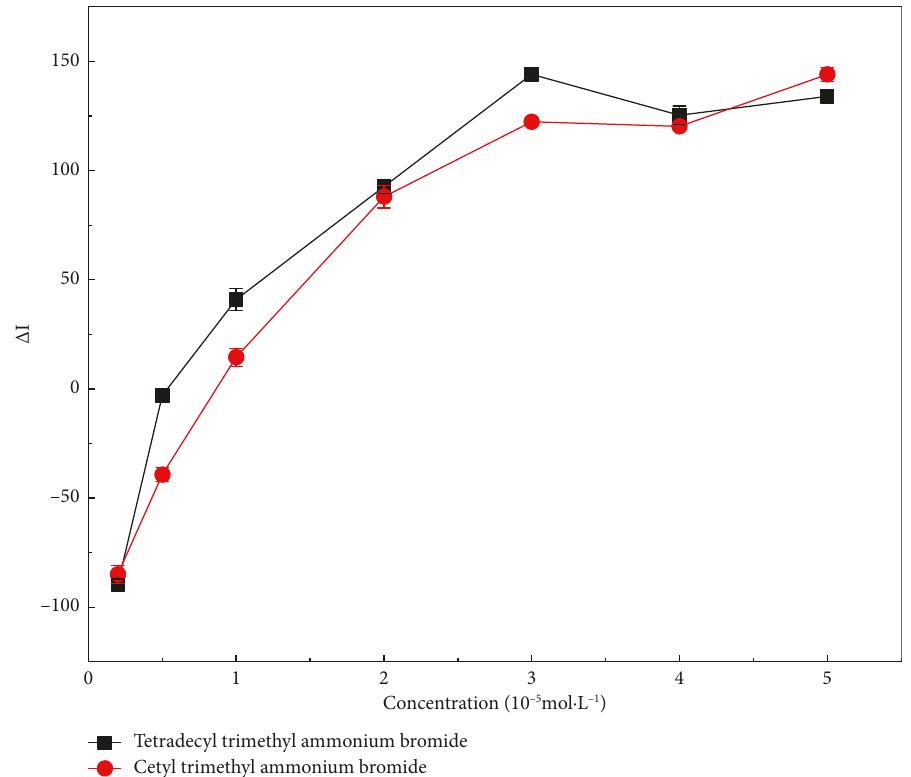
Figure 4: Resonant Rayleigh scattering spectra after addition of cationic surfactant to congo red-neomycin system. The concentration of tetradecyl trimethyl ammonium bromide and cetyl trimethyl ammonium bromide: 0.2, 0.5, 1, 2, 3, 4, 5